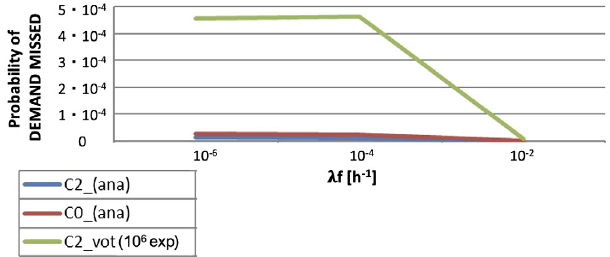
FIG. 17. Probability of demand missed against λ f (explicit simulation with 10 6 cycles for varied parameters in C2_vot).